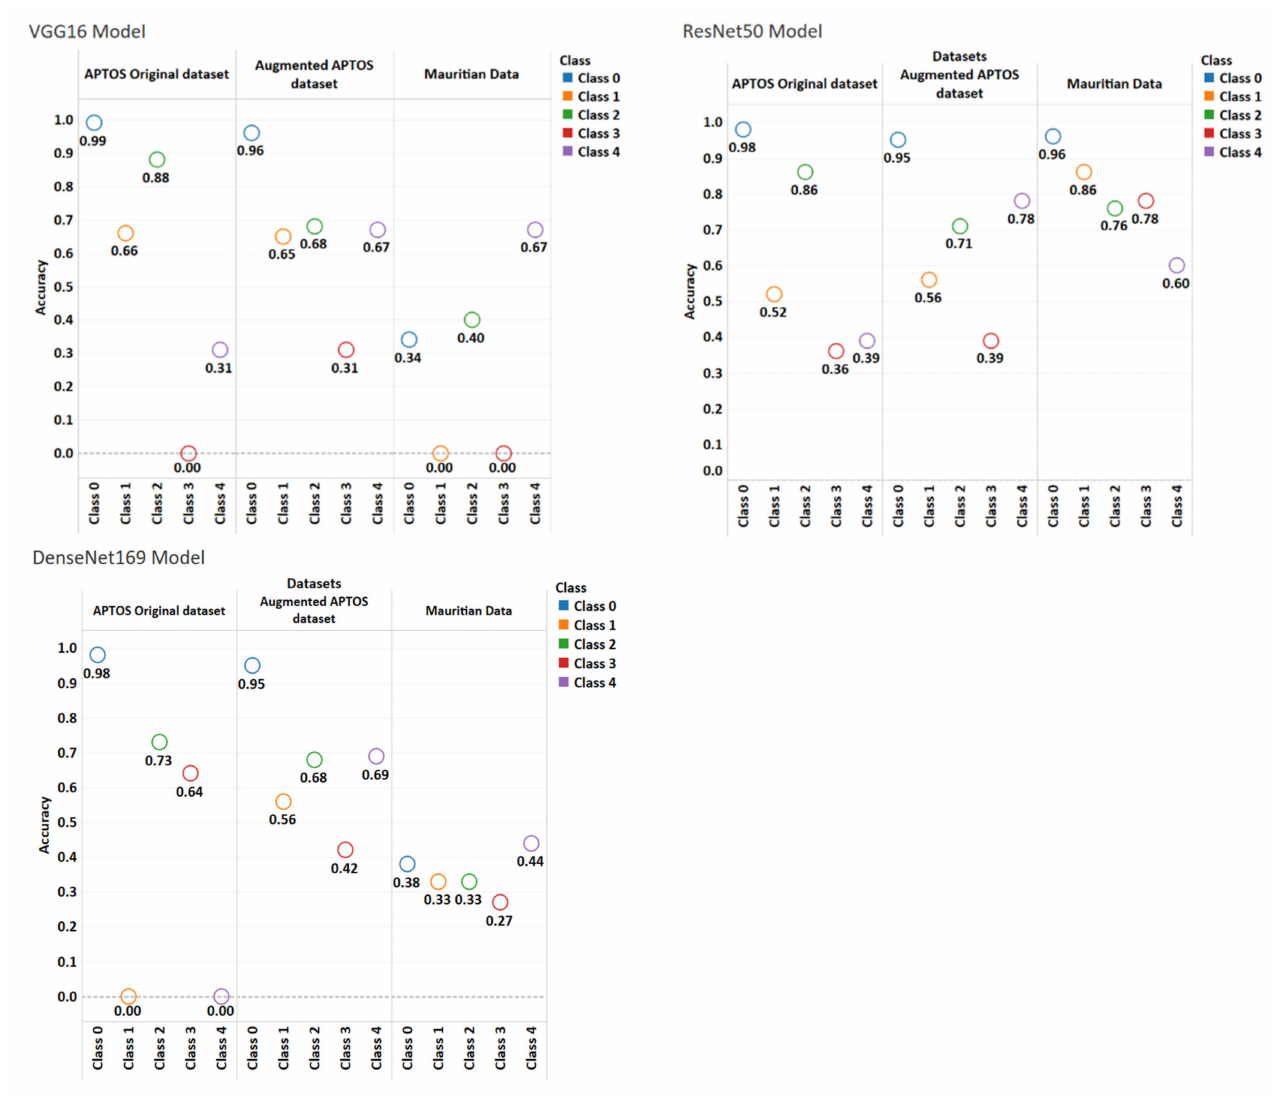
Figure 11. Detailed testing accuracy for each class for the 3 datasets and the 3